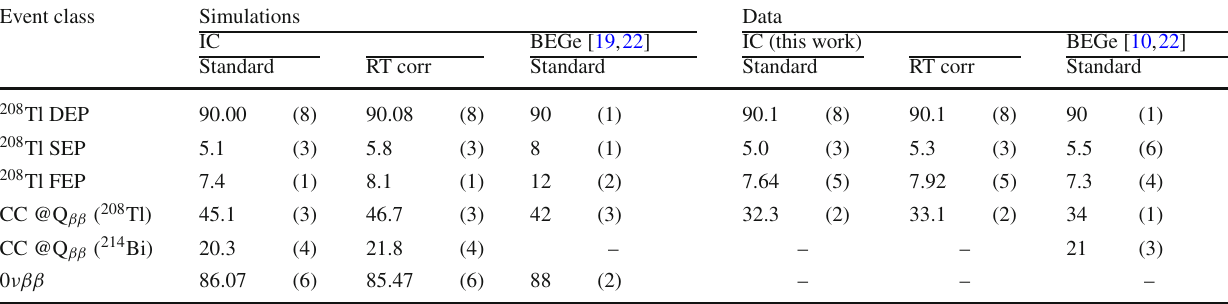
Table 1 Percentage of events classified as single-site for different event samples and detectors, taken from simulations and experimental data. For inverted coaxial detectors, the results are given both before ( Standard ) and after a correction based on the rise time ( RT corr ) Event class Simulations Data IC BEGe [19,22] IC (this work) BEGe [10,22] Standard RT